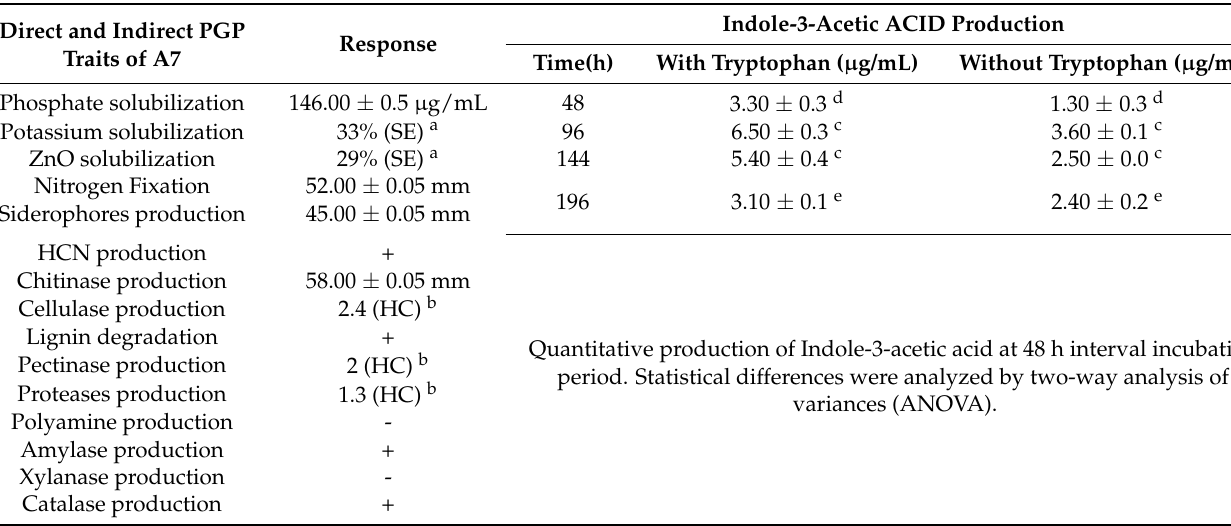
Table 4. Plant-growth-promoting activities of the strain A7 and its enzymatic